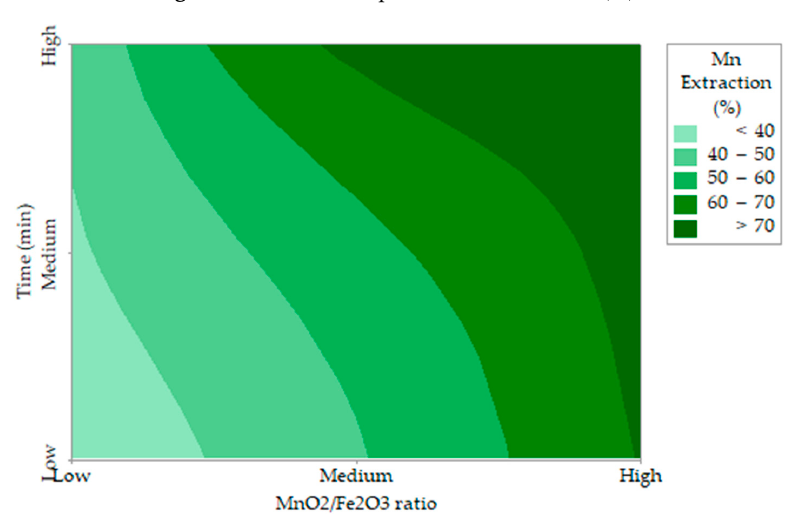
Figure 3. Contour plot of Mn extraction (%) versus MnO 2 / Fe 2 O 3 , time (min).